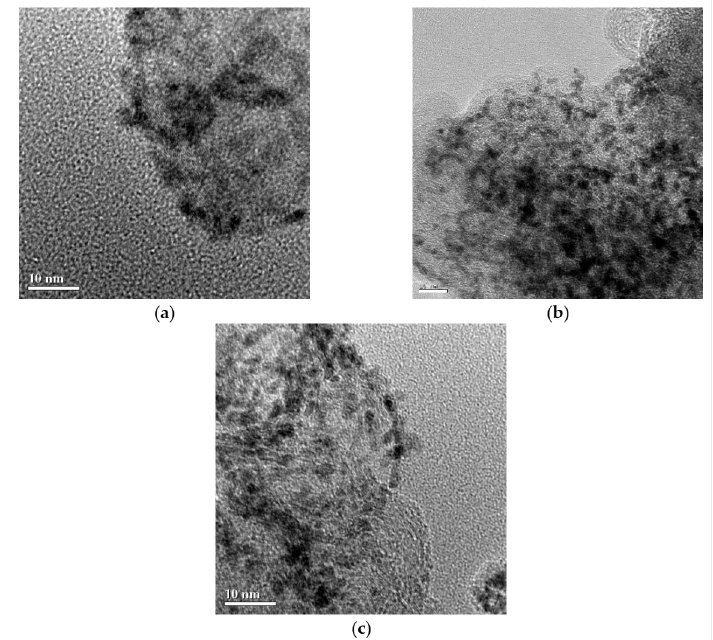
Figure 4. TEM images of the catalyst which was modified by H 2 O 2. and reduced by NaH 2 PO 2 . ( a ) PtRu/carbon; ( b ) PtRu/carbon-01; ( c )